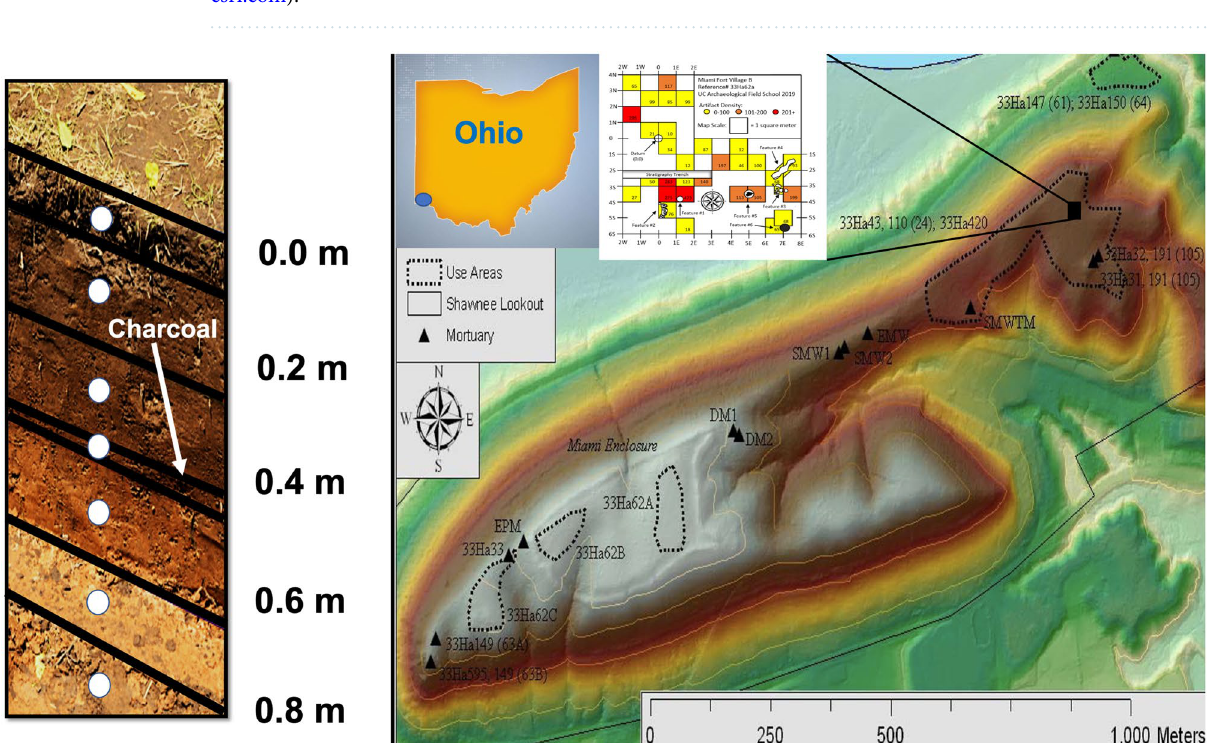
Figure 5. The location, stratigraphy, and sediment sample sites (white circles) of the Miami Fort earthworks and village site, Hamilton County, Ohio. Kenneth Barnett Tankersley used Microsoft PowerPoint for Mac Version 16.41 (www. micro soft. com) to create this figure. The GIS map was produced in ESRI ArcGIS 10.3.1 software (www. esri.